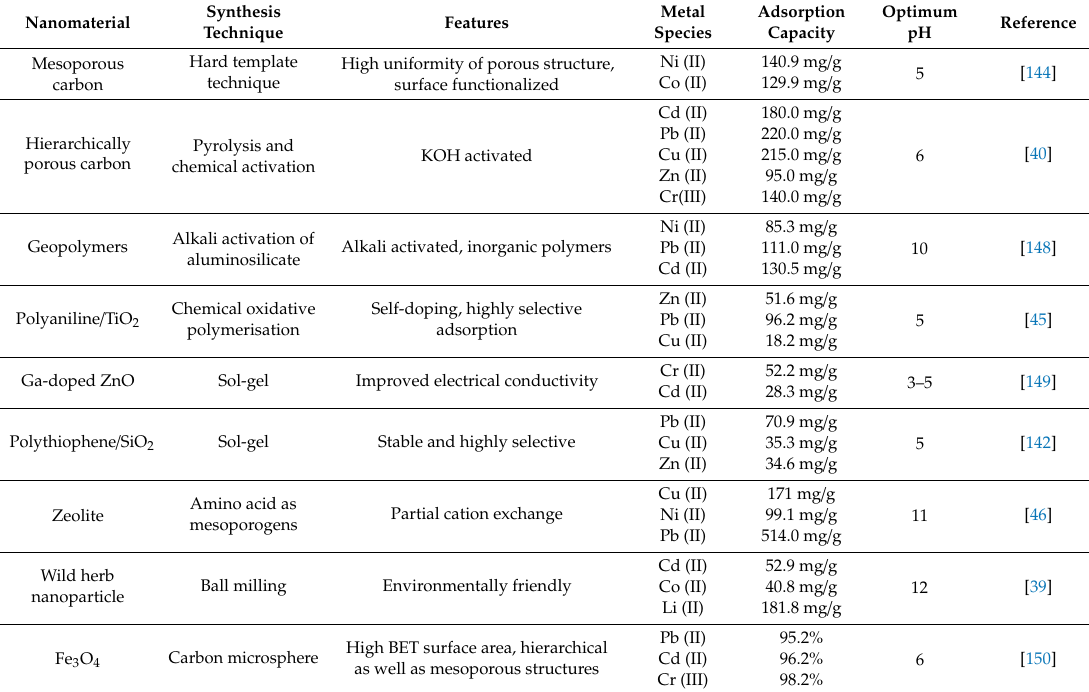
Table 4. Recent literature on the development of various types of adsorbent for the removal of HM ions from